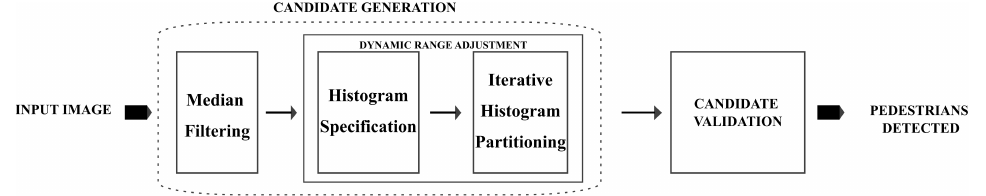
Figure 3. Overview of the proposed method.